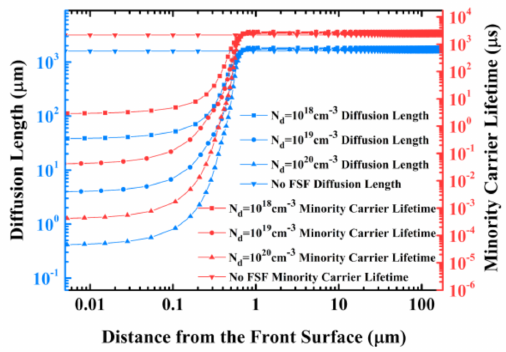
Figure 4. Di ff usion length and minority carrier lifetime versus distance from the front surface of the IBC solar cell model for di ff erent front surface field (FSF) doping